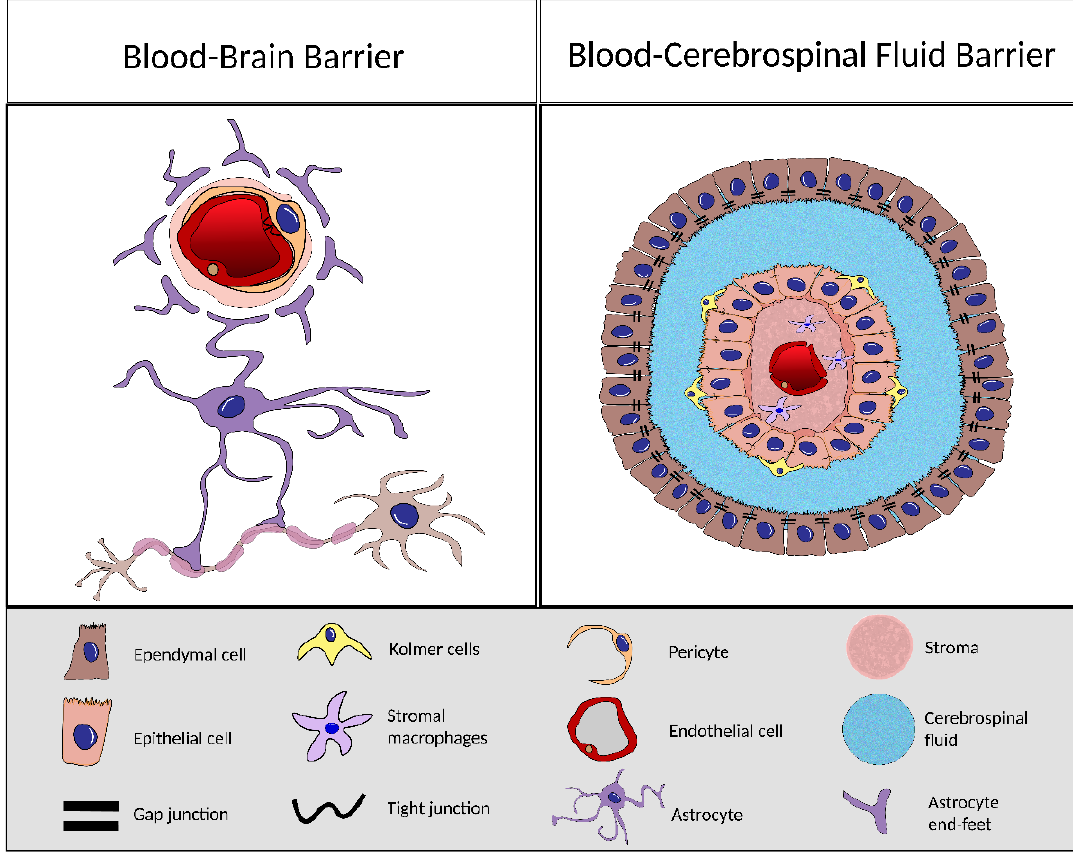
Figure 1. Schematic representation of the blood–brain barrier (BBB) and blood–cerebrospinal fluid barrier (BCSFB), depicting the cellular constituents of each